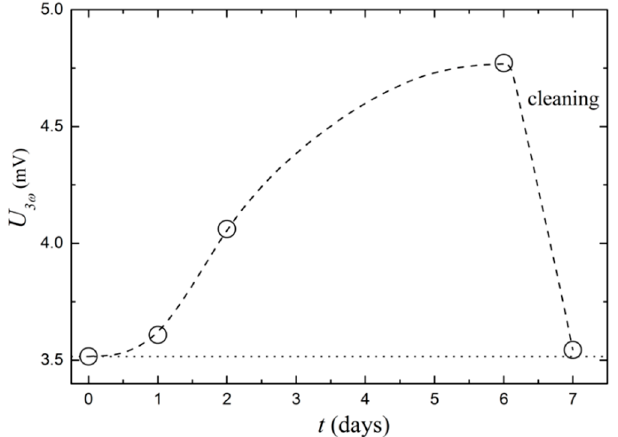
Figure 9 . Sensor in a bacterial growth environment showing (cid:1847) (cid:2871)(cid:3104) as a function of time over six days. Figure 9. Sensor in a bacterial growth environment showing U 3 ω as a function of time over six days. On day seven, the sensor is cleaned and (cid:1847) (cid:2871)(cid:3104) regains its initial value. The dashed line is a guide to the On day seven, the sensor is cleaned and U 3 ω regains its initial value. The dashed line is a guide to the eye and the dotted line is the (cid:1847) (cid:2871)(cid:3104) magnitude for the clean sensor at day zero. eye and the dotted line is the U 3 ω magnitude for the clean sensor at day